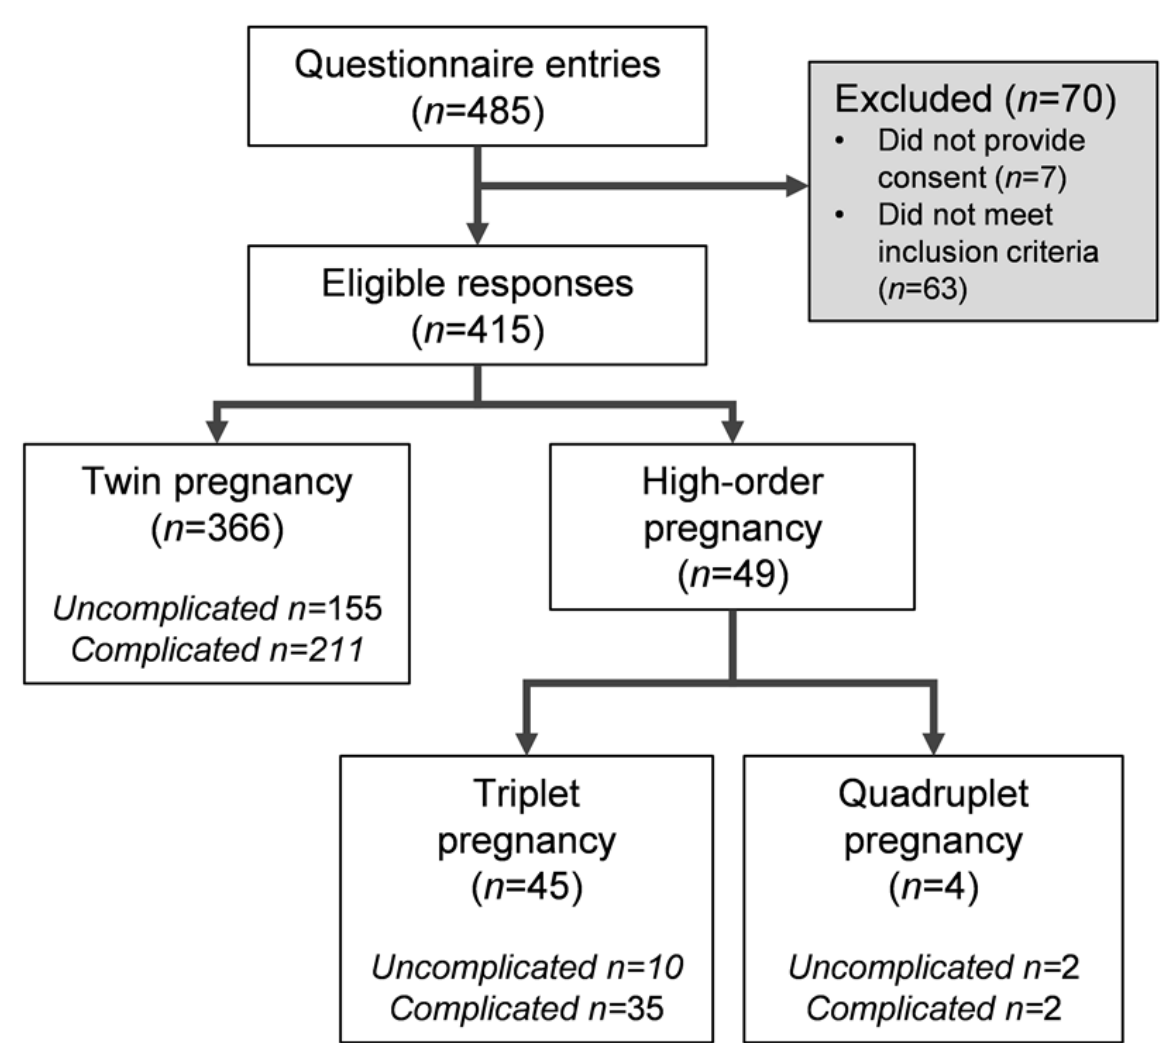
Figure 1. Study recruitment flowchart. Responses were excluded if: full consent was not provided, participants reported having only a singleton pregnancy or incomplete data with no responses to physical activity questions were submitted. “Uncomplicated” refers to participants that reported no pre-existing or prenatal medical conditions that would contraindicate physical activity; “complicated” refers to pre-existing conditions or development of pregnancy-specific maternal or fetal complications during multifetal pregnancy (e.g., hypertensive disorders, gestational diabetes, preterm labor, growth restriction, etc.) that would contraindicate physical activity in this population.